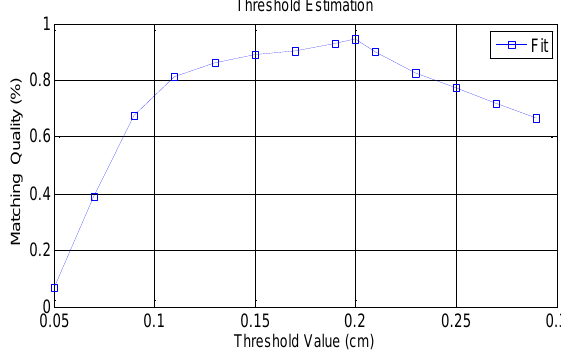
Figure 2: Threshold value and quality measure for